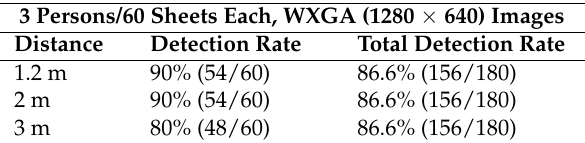
Table 4. Upper Body Detection Rate.